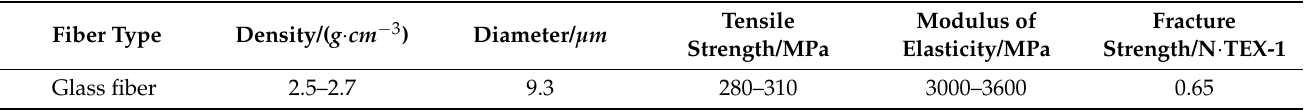
Table 2. Physical properties of glass